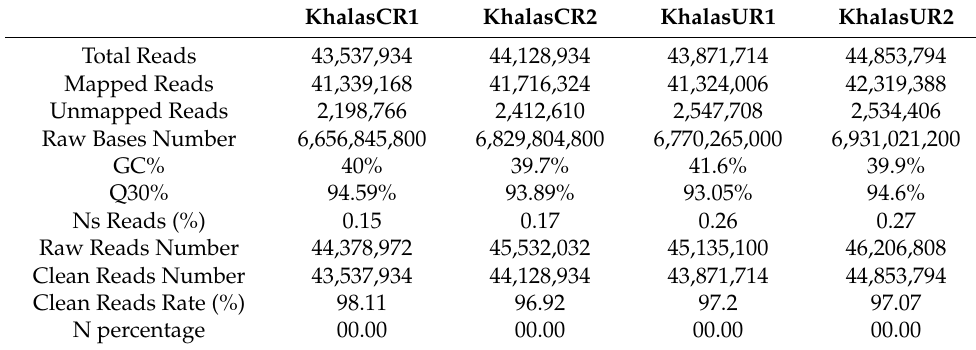
Table 1. Transcriptome sequencing statistical summary of sequenced and assembled results.